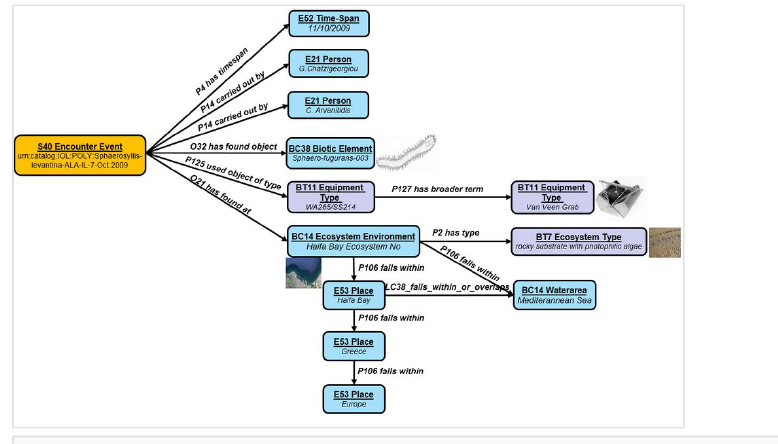
Occurrence Event Conceptual Modeling